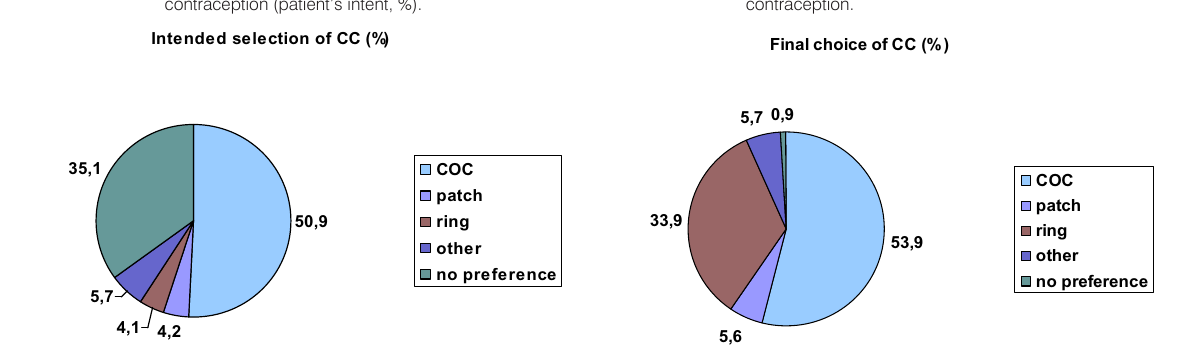
Figure 1. Intended choice of administration of combined hormonal contraception (patient’s intent, %).